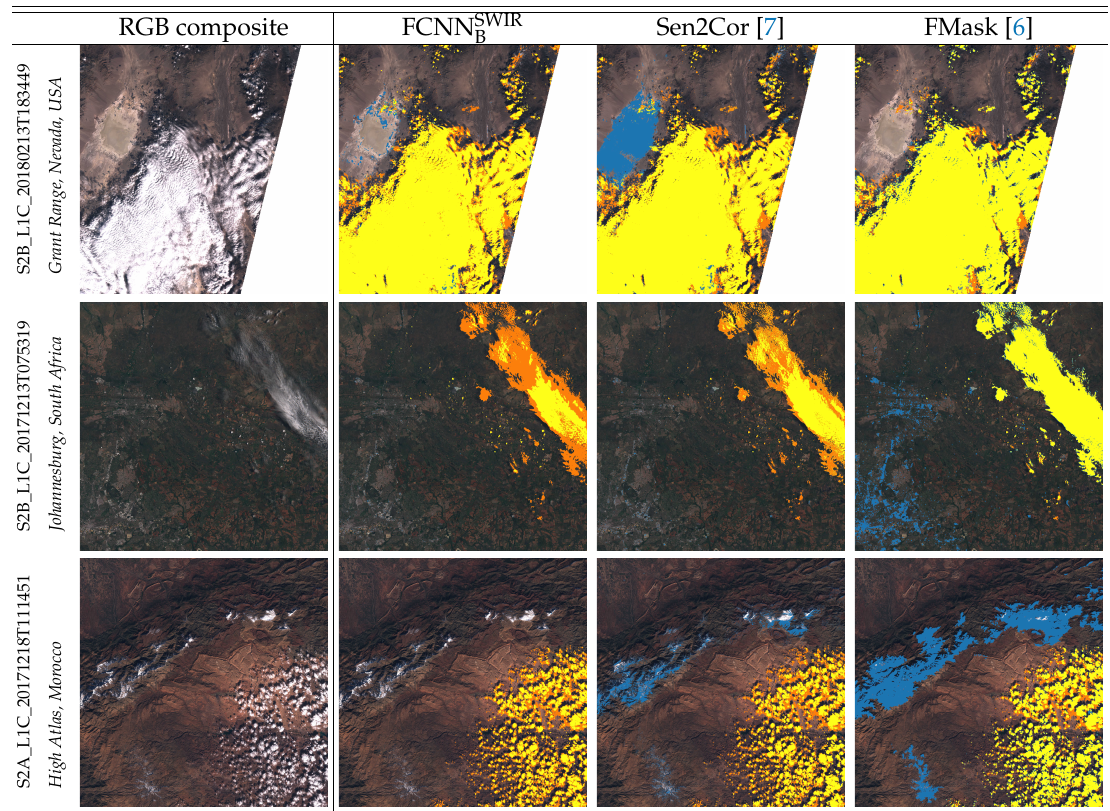
Figure 5. Visual differences between the ground truth and FCNN SWIR , operational L2A processor Sen2Cor, and FMask B for three Sentinel-2 images from the S2-BaetensHagolle dataset. Each row displays a different scene, and the models are arranged by columns. The first column shows RGB. Comparisons between the cloud masks and ground truth are superimposed to the RGB images in the other